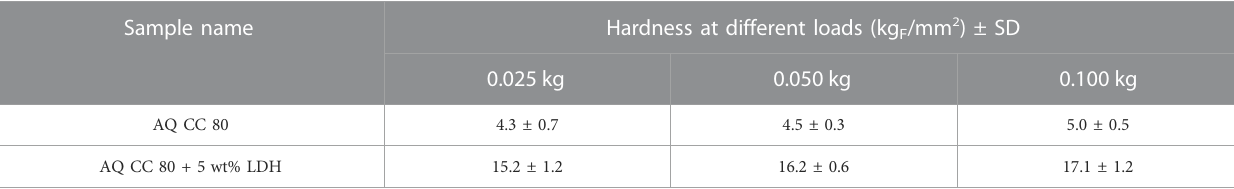
TABLE 1 Vickers microhardness testing of the acrylic polyurethane coating with and without Mg-Al/[Fe(CN) 6 ] LDH nanoadditive (loading time 15